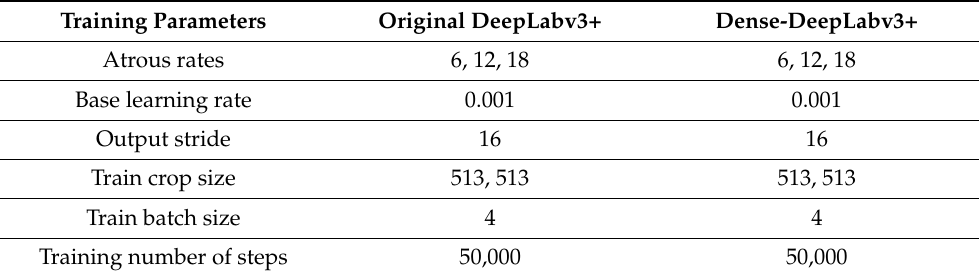
Table 1. Network parameters setting